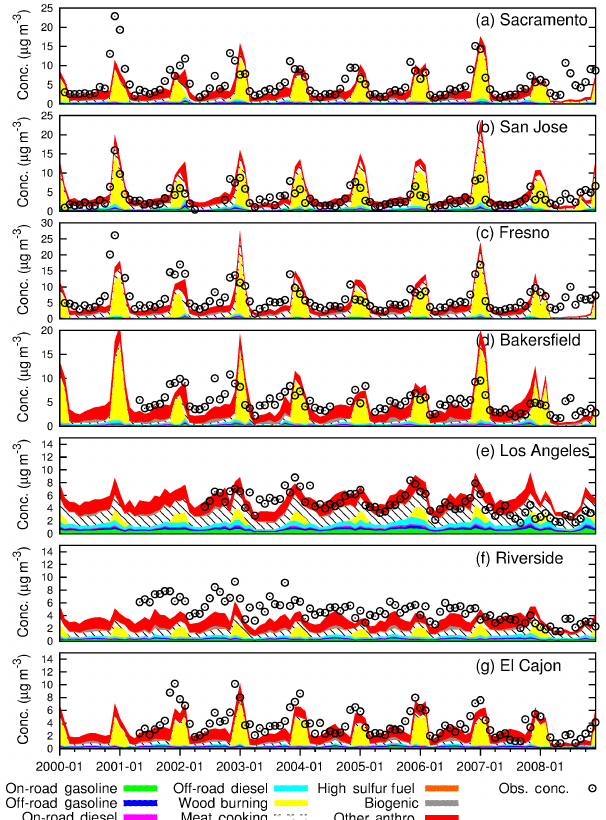
Figure 1. Monthly source contributions to PM 2 . 5 total OC at seven urban sites. Observed total OC concentrations are indicated by the circles with dots, and predicted OC concentrations from different sources are indicated by the colored